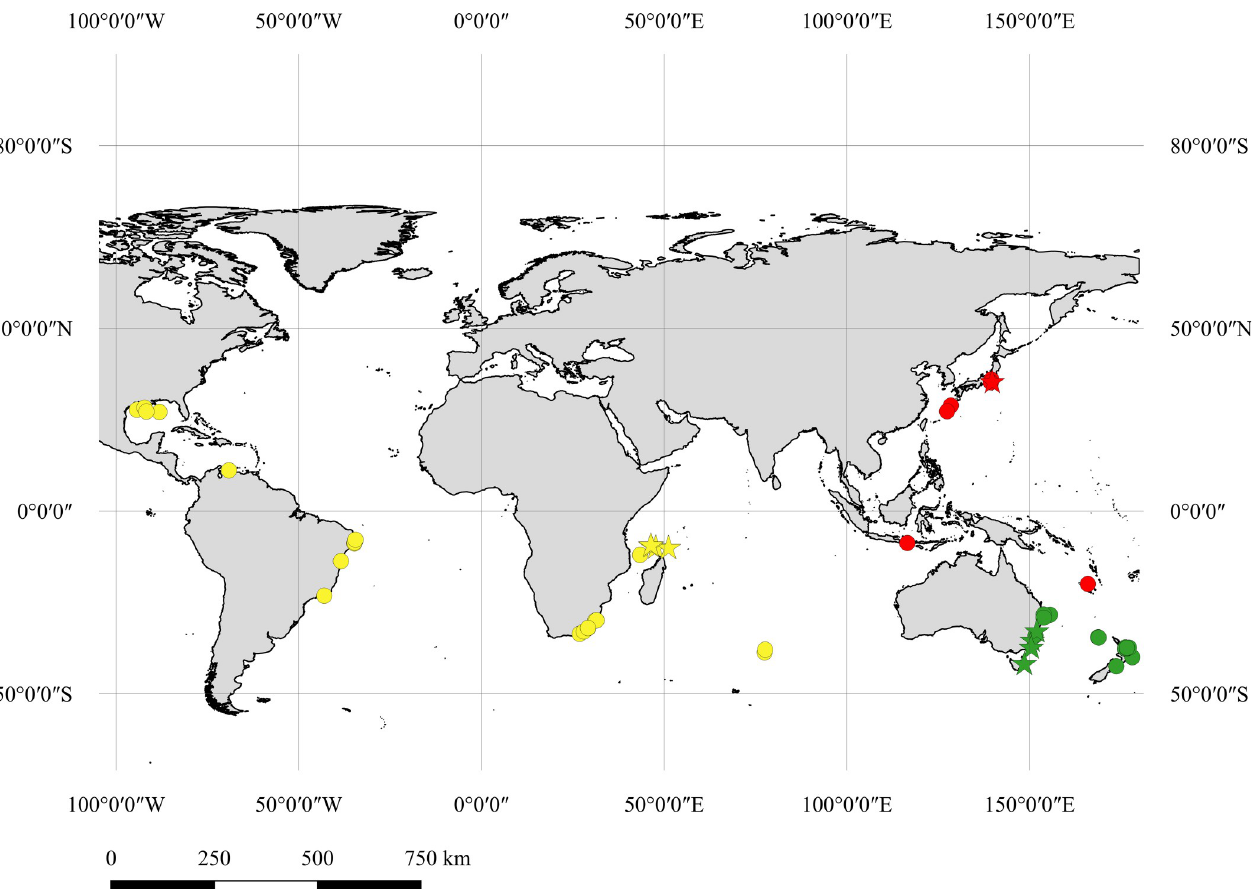
Fig 15. Map of the geographical distribution of Cirrhigaleus species. Stars: type material; dots: other material; red symbols: C . barbifer ; green symbols: C . australis ; yellow symbols: C . asper